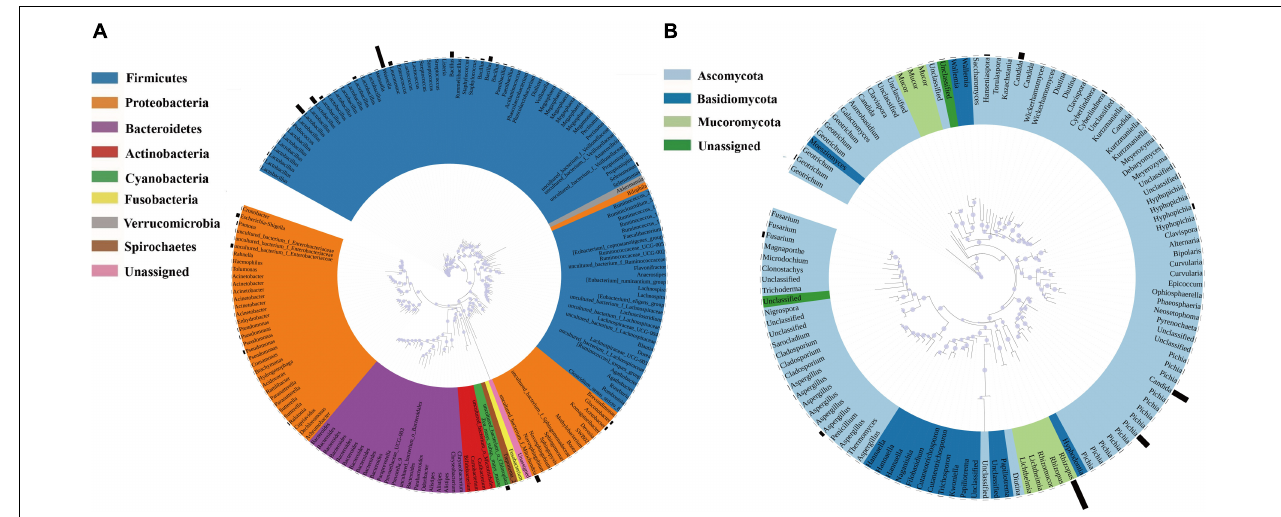
FIGURE 2 | Phylogenetic tree of bacterial (A) and fungal OTUs (B) found in all samples. Color ranges identify phyla within the tree. Bars represent the relative abundance of each OTU in all samples.